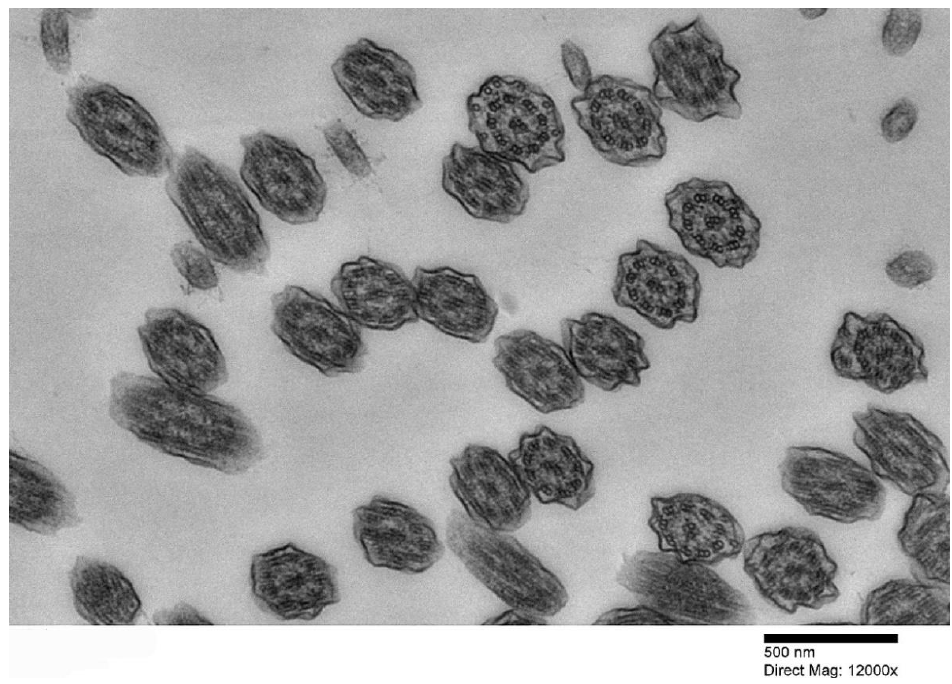
Figure 2. Cilia of a healthy individual showing a classic arrangement (transmission electron mi- croscopy, see the bar for details regarding magnification). Some of these tangential sections were cut midway between the cell surface and the top of the waves. Ciliary cross-sections represent cilia in wave crests. Some cross-sections are not in focus because of the specific cut occurring at the time of the ciliary stroke. This is due to the technical difficulty in having all cross-sections with the same planar cut section.